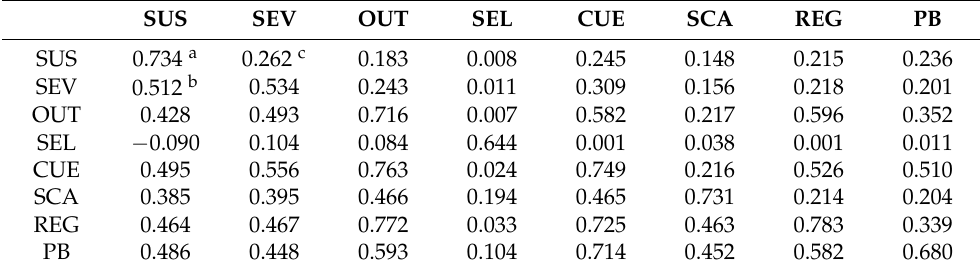
Table 5. AVE, correlations, and squared correlations of the constructs.